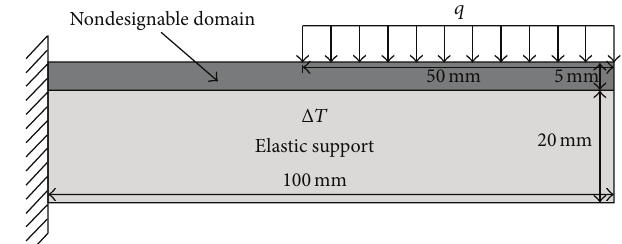
Figure 5: Definition of the 2D cantilever beam.